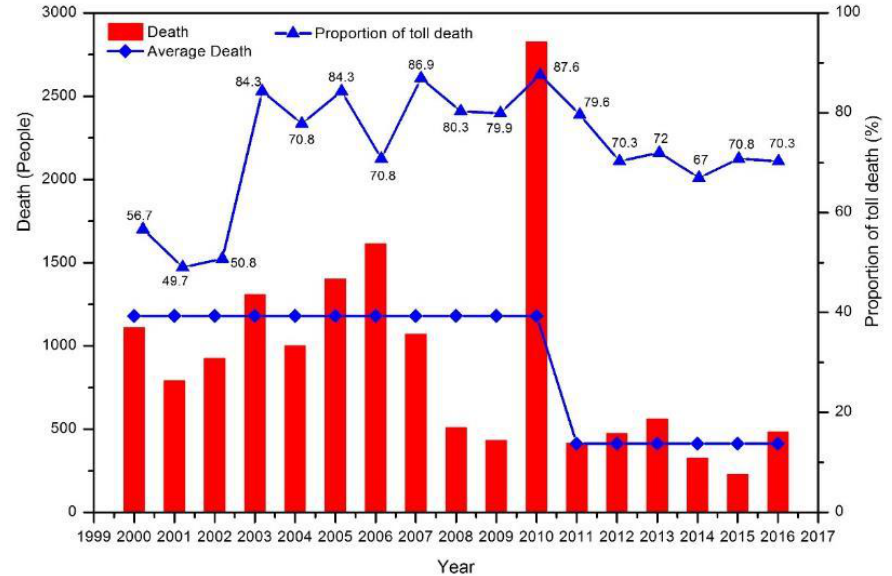
Figure 2. Number of deaths due to flash floods and their ratio to the total deaths caused by floods. Table 2. Typical events of heavy rainfall and flash floods in 2016.